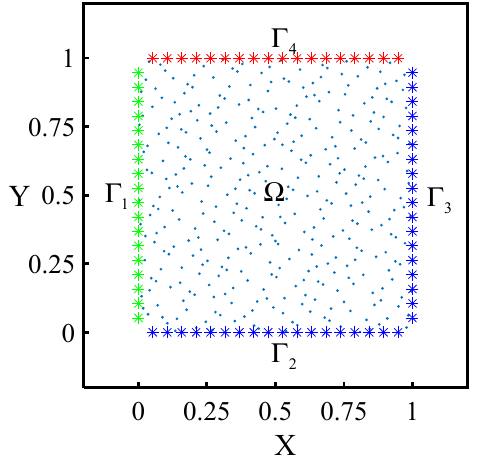
Figure 3. Collocation nodes’ distribution.